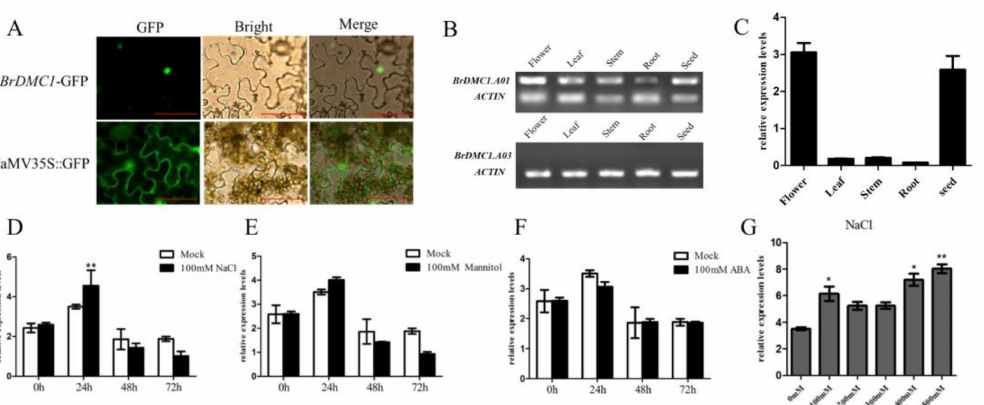
Figure 4. Expression pattern and subcellular localization of BrDMC1 . ( A ) Subcellular localization of the fused 35S:: BrDMC1 -GFP in N. benthamiana leaf cells. Bar = 50 µ m. ( B ) Expression pattern of BrDMC1 in different tissues. ( C ) qRT-PCR analysis expression levels of BrDMC1 in different tissues. ( D – G ) BrDMC1 expression levels in different treatments and different times. (** p < 0.01, * p < 0.05.) The level of BrDMC1 expression in different tissues of B. rapa showed that the BrDMC1 .A03 (ID: Bra001890) did not have transcriptional activity (Figure 4B). BrDMC1